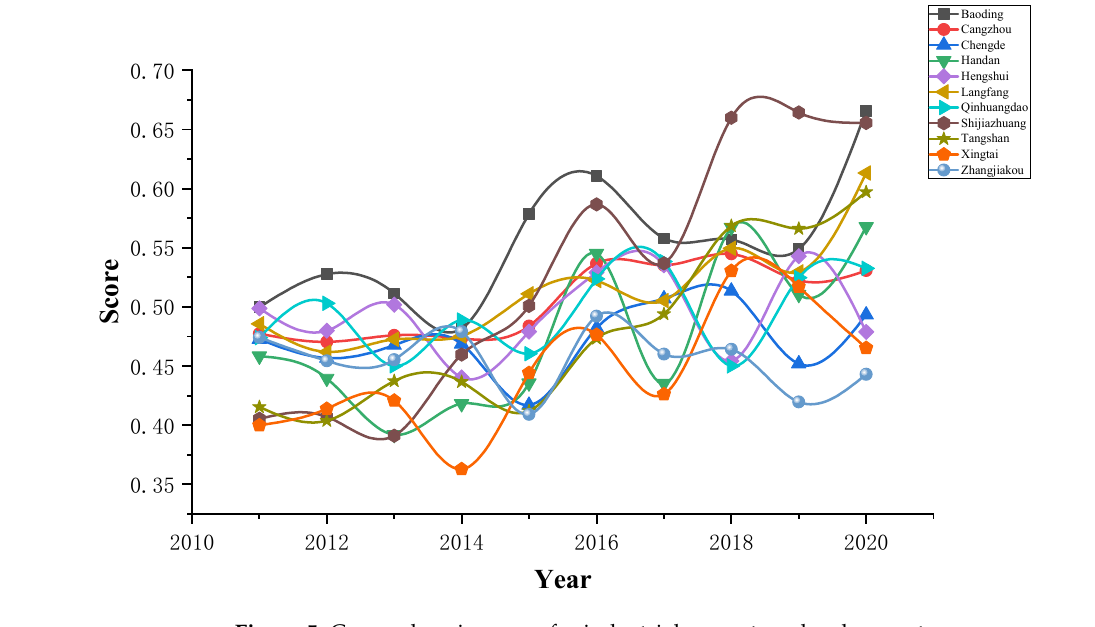
Figure 5. Comprehensive score for industrial ecosystem development.